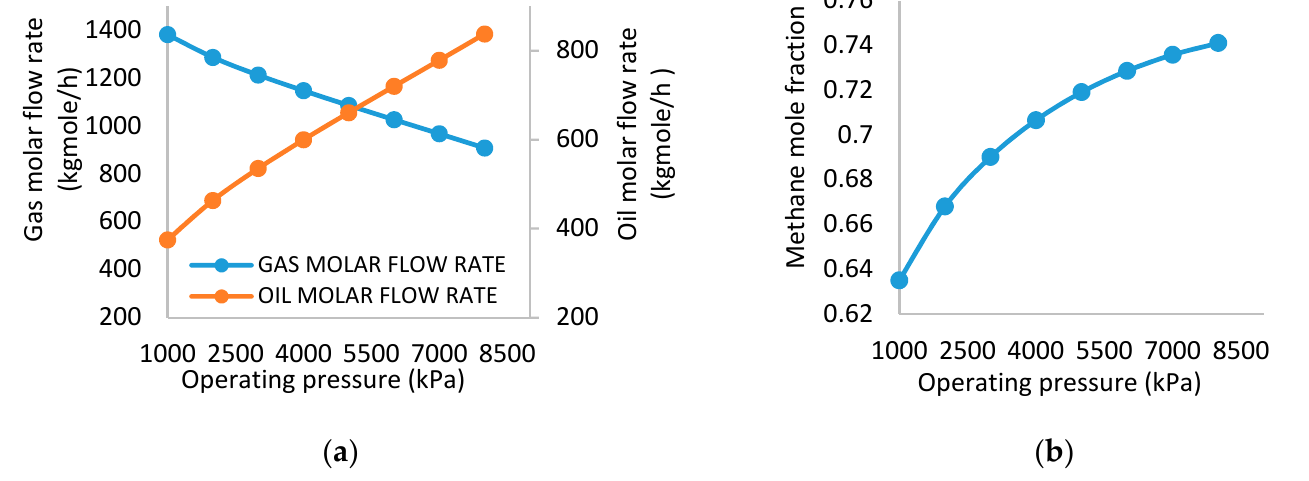
Figure 2. ( a ) Effect of separator pressure on gas molar flow rate and oil molar flow rate. ( b ) Effect of separator pressure on methane mole fraction.